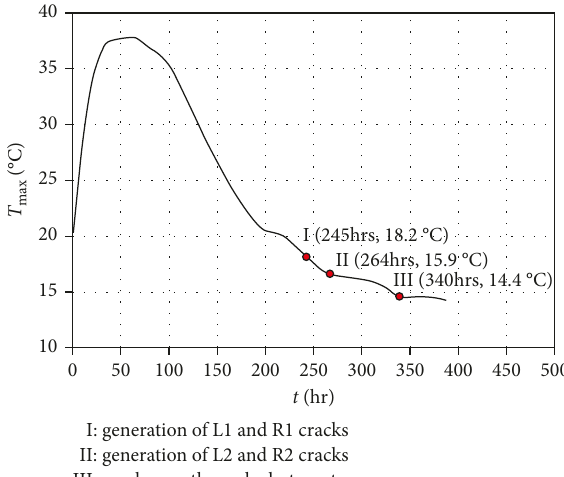
Figure 12: Main crack state corresponding to hydration time of the abutment